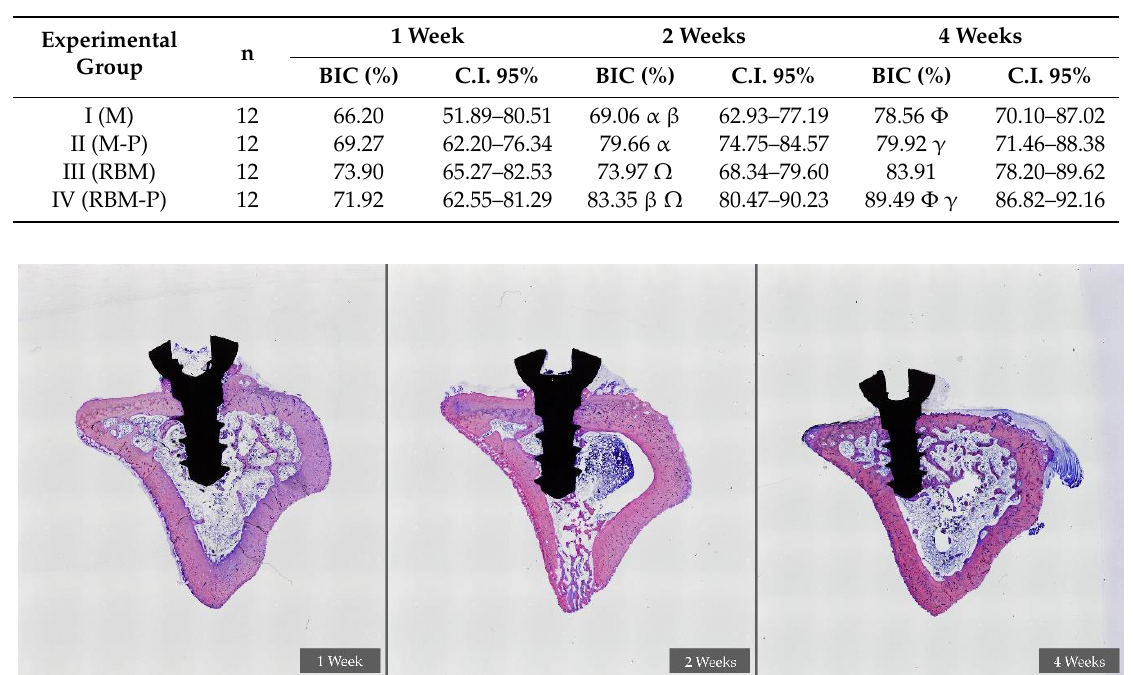
Figure 4. BIC percentages with the C.I. (95%) of each experimental group obtained by histological Image 2. Histological preparations at one, two, and four weeks after implant placement. evaluation at one, two, and four weeks. p values = ( α ) 0.018; ( β ) 0.001; ( Ω ) 0.035; ( Φ ) 0.018; ( γ )